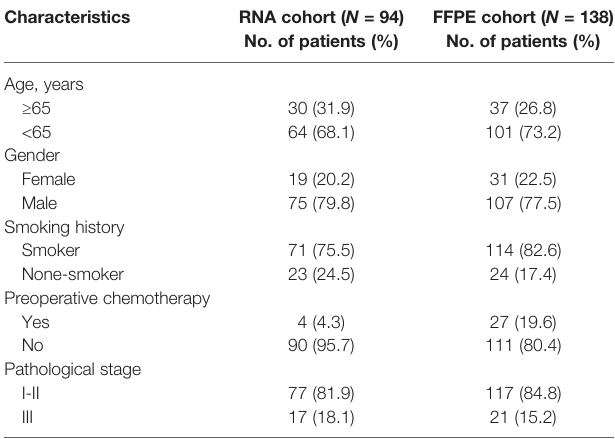
TABLE 1 | Demographic and clinical information related to the tumor samples from two cohorts.